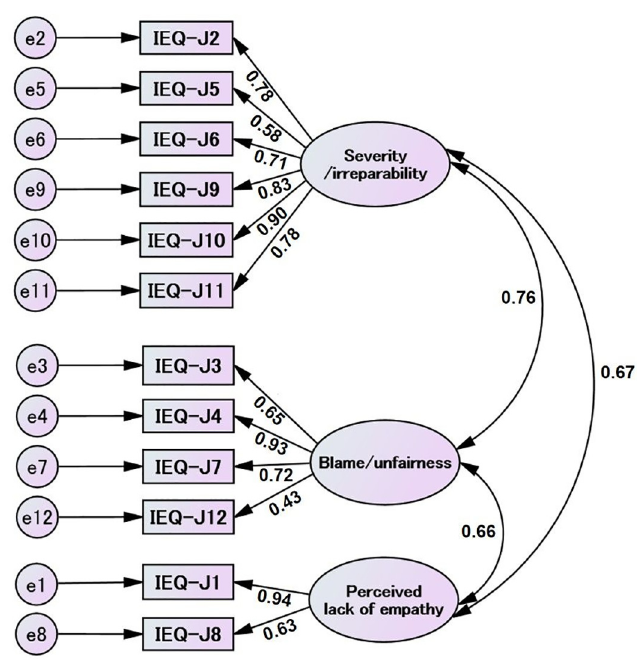
Fig 2. Three-factors model of the IEQ-J. Three-factors model of the IEQ-J, and Error terms (e1 – e12) are also indicated. Note. IEQ-J, Japanese version of Injustice Experience Questionnaire